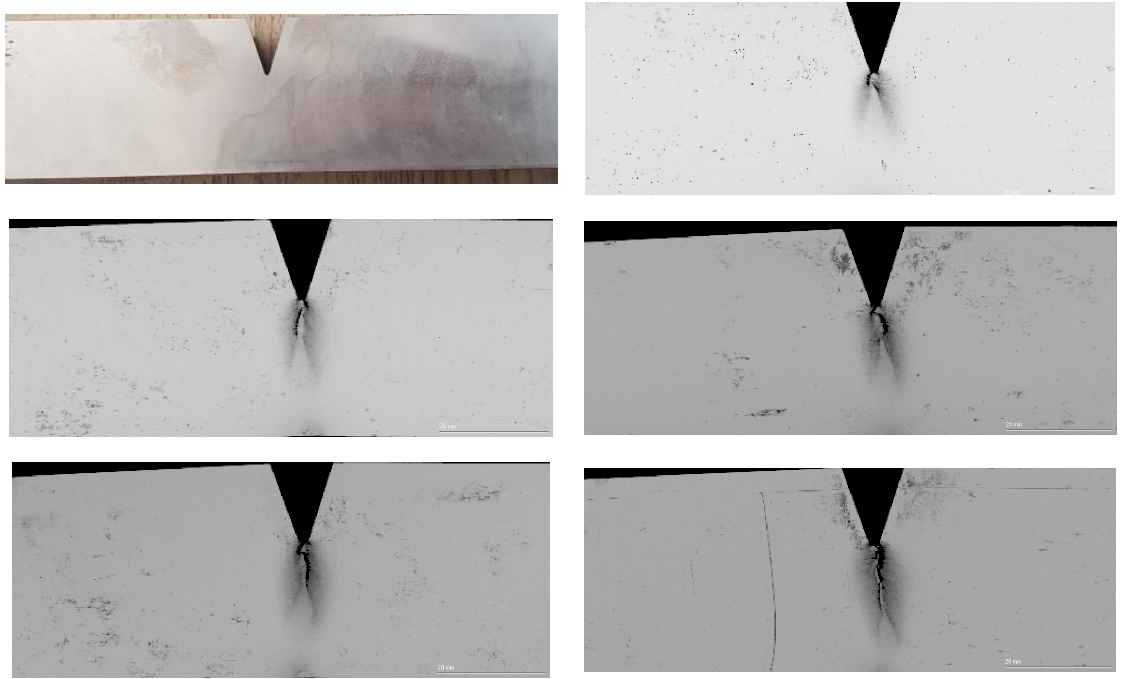
Figure 2. The crack under ultrasonic microscope.